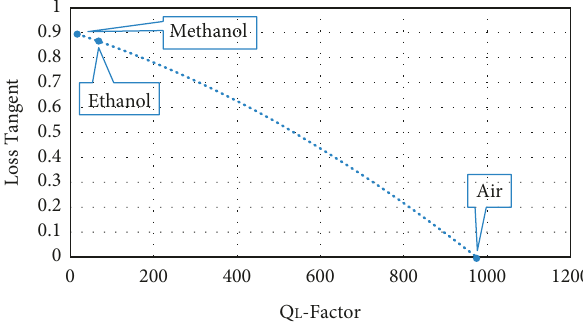
Figure 11: Measured polynomial fitting curve of loss